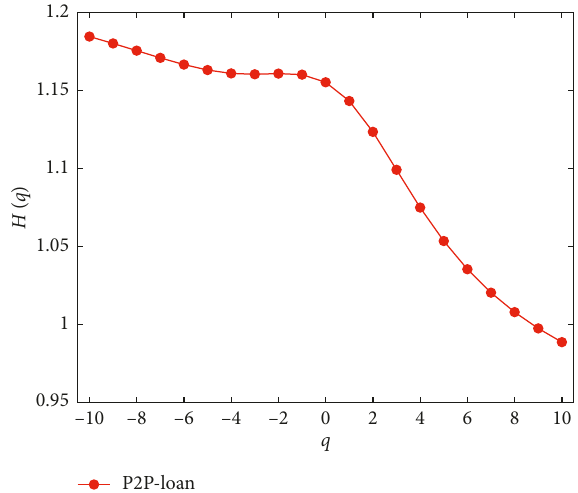
( s ) versus s for P2P-loan. xyq